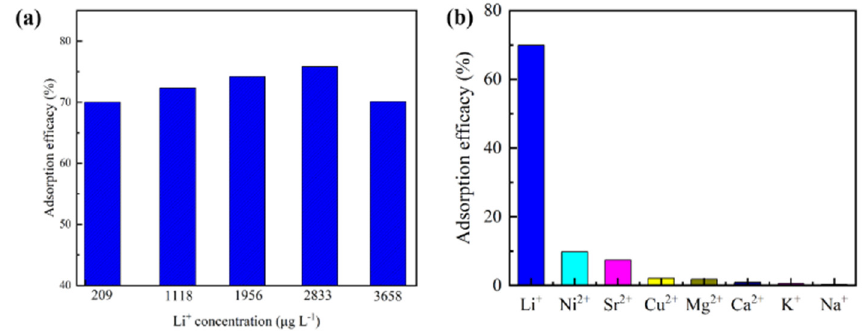
Figure 11. ( a ) Li + adsorption efficiency of HTO/CA in seawater with different Li + concentrations ( C 0 = [Li + ] = 209–3658 μ g L − 1 , pH = 8.25, V = 160 mL, m ≅ 100 mg); and ( b ) cation adsorption efficiency of HTO/CA in seawater (concentration of cations in seawater: [Li + ] = 209 μ g L − 1 , [Ni 2+ ] = 0.461 μ g L − 1 , [Sr 2+ ] = 0.729 μ g L − 1 , [Cu 2+ ] = 0.241 μ g L − 1 , [Mg 2+ ] = 1143 μ g L − 1 , [Ca 2+ ] = 457 μ g L − 1 , [K + ] = 326 μ g L − 1 , [Na + ] = 10,110 μ g L − 1 ; pH = 8.25, V = 160 mL, m ≅ 100 mg).